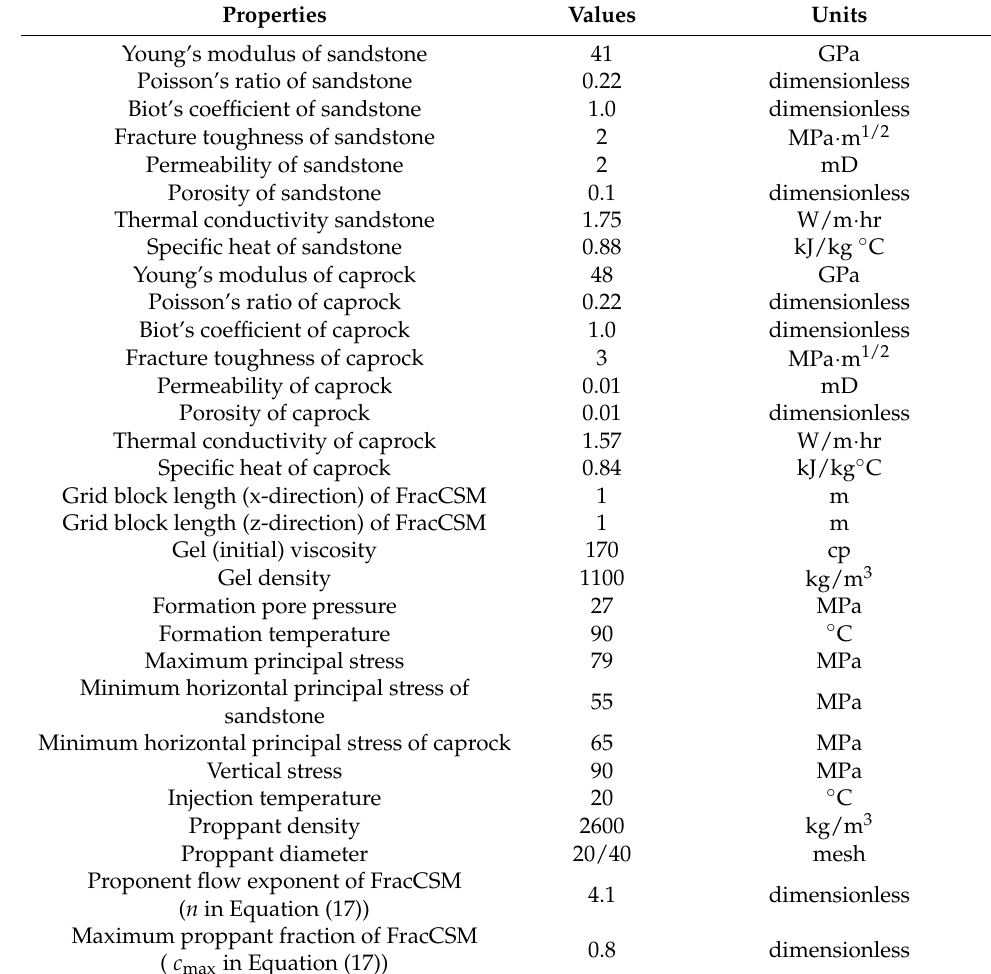
Table 1. Parameters for the comparison with Fracpro PT.